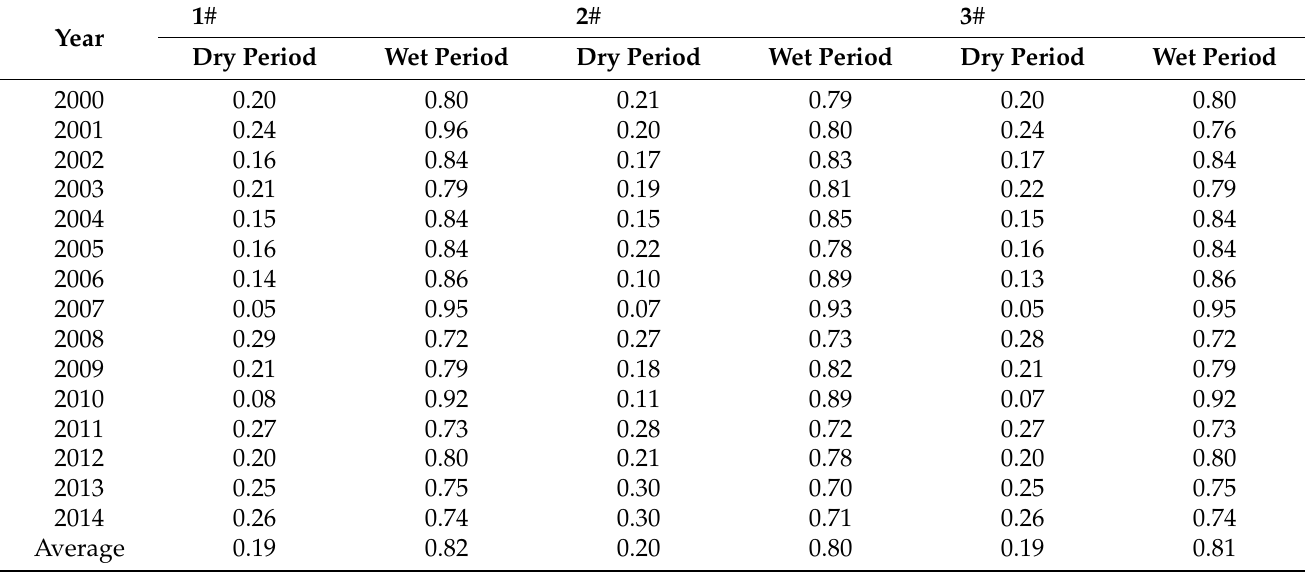
Table 3. The proportion of rainfall in each wet and dry period from 2000 to 2014.